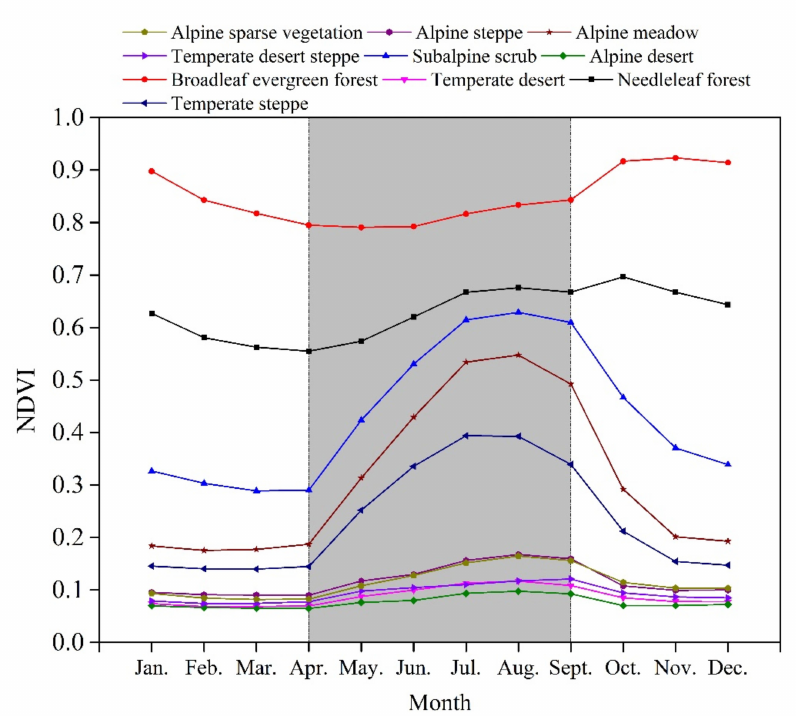
Figure 4. The annual variation of the monthly average NDVI for each vegetation type on the Tibetan Plateau from 1985 to 2015. The period from April to September is the analysis period in each